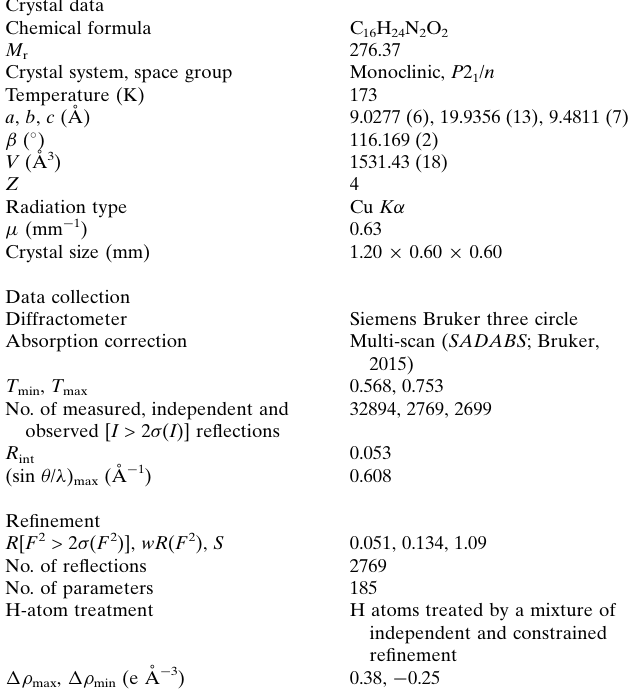
Table 2 Experimental details.